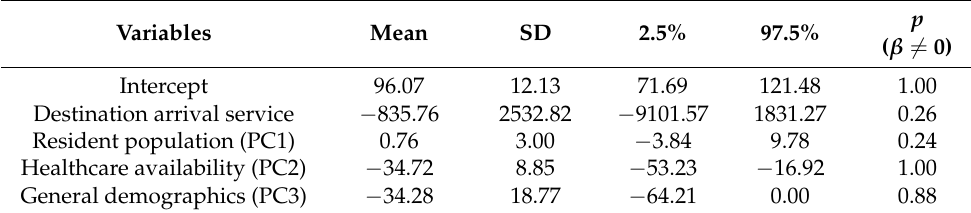
Table 2. The regression coefficients of destination arrival service and principal components of the socioeconomic indicators in the Bayesian multivariate model.